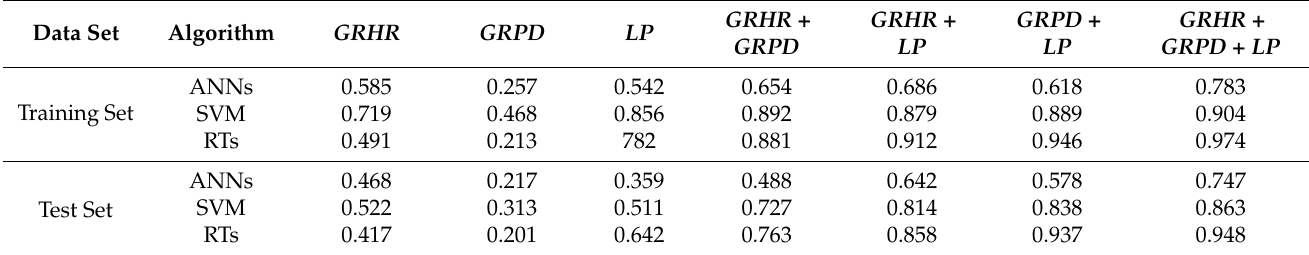
Table 8. Accuracy of three classification algorithms under different feature